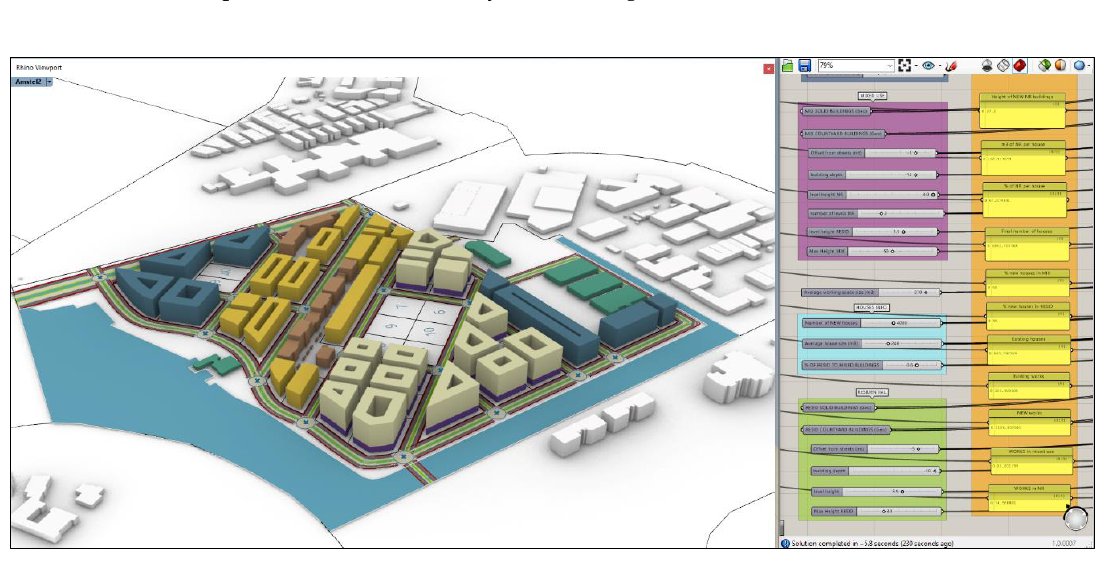
Figure 21. Example of the Graphical User Interface of the parametric modelling tool in Rhinoceros / Grasshopper. On the left, 3D visualization in the Rhinoceros viewport. On the right, the Grasshopper window with information panels and data nodes.